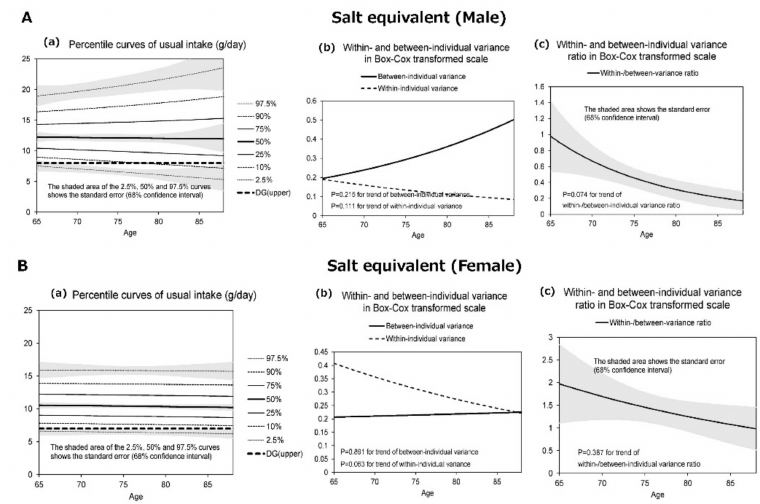
Figure 2. The percentile curves of usual nutrient intake of salt equivalent by age (male and female).